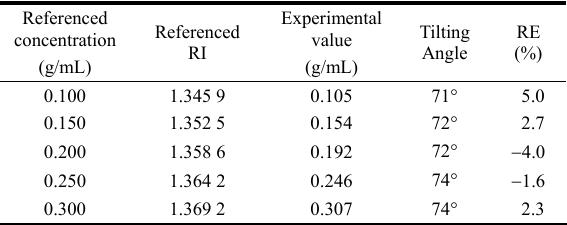
Fig. 5 Normalized intensity of the reflected light collected by four output fibers with tilting angles of 69°, 71°, 72°, and 74°, respectively. Table 1 Measurement results of the concentration of cane surge obtained by using three output fibers with different tilting